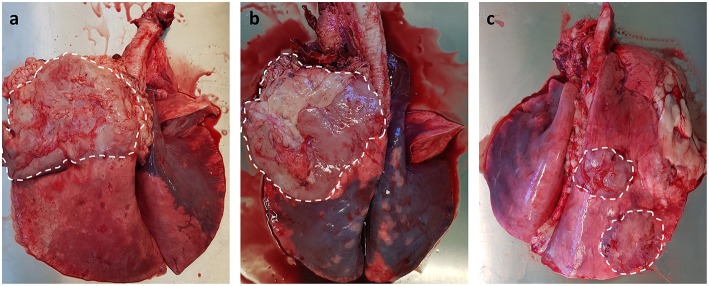
Gross pathology of OPA tumors. (a,b) Large single advanced OPA tumors affecting the entire left cranial lung lobe. The lesions are gray in color with a clear distinct boundary between neoplastic tissue and the neighboring pink aerated lung. Extensive fibrous tissue can be seen attached to the overlying pleura of the tumor. (c) Two discrete OPA tumors within the right cranial and caudal lung lobes.